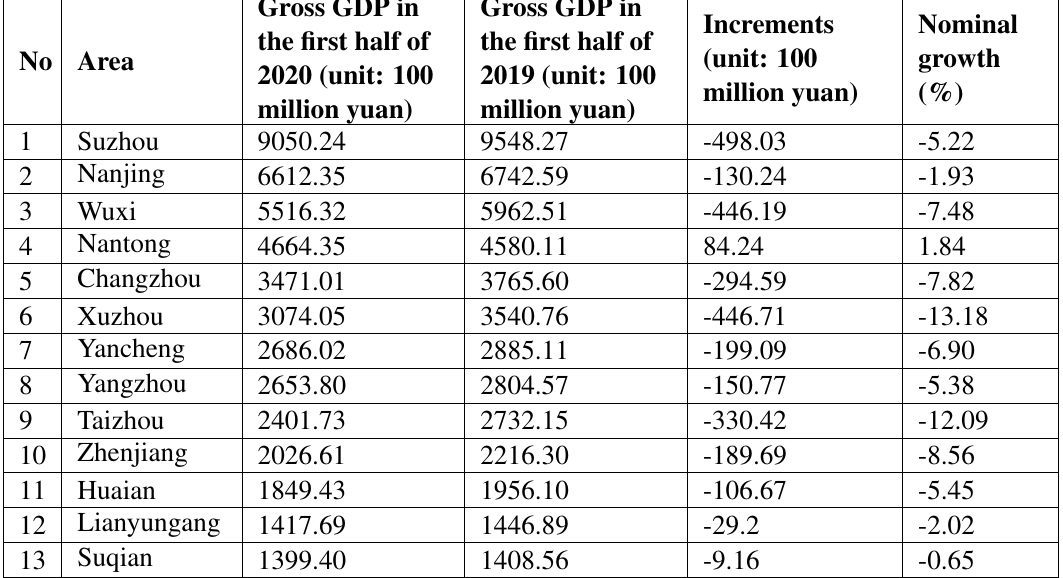
Table 3 Comparison of GDP increment in the first half of 2019 and the first half of 2020 (100 million yuan) Gross GDP No Area